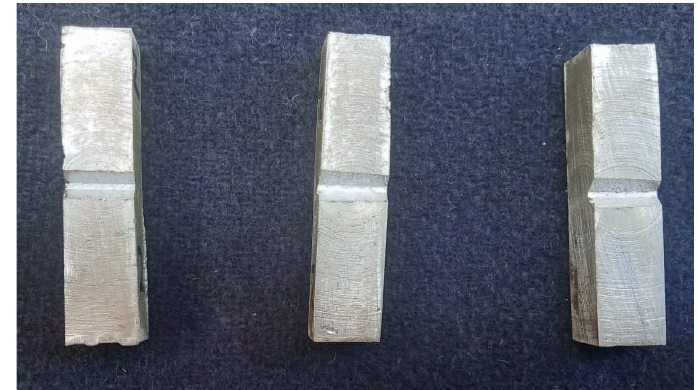
Figure 4. Impact test specimen.